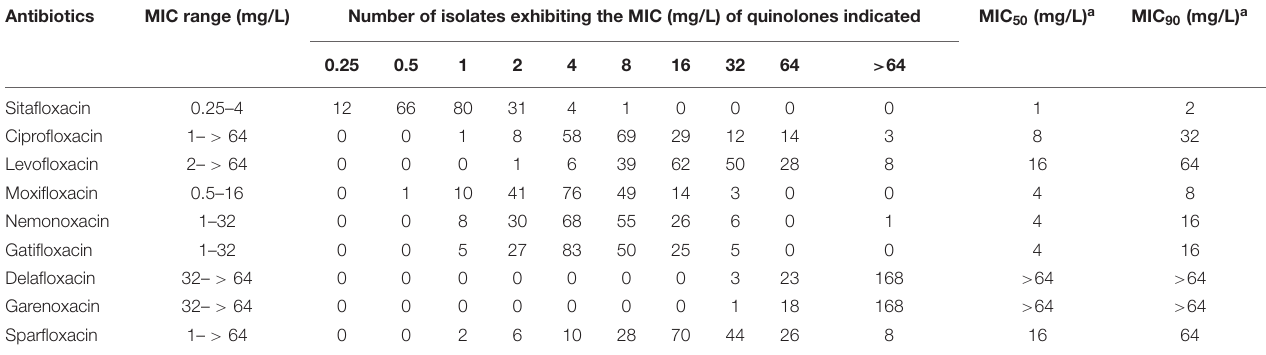
TABLE 1 | MIC of 9 quinolones for 194 clinical M. abscessus isolates. Antibiotics MIC range (mg/L) Number of isolates exhibiting the MIC (mg/L) of quinolones indicated